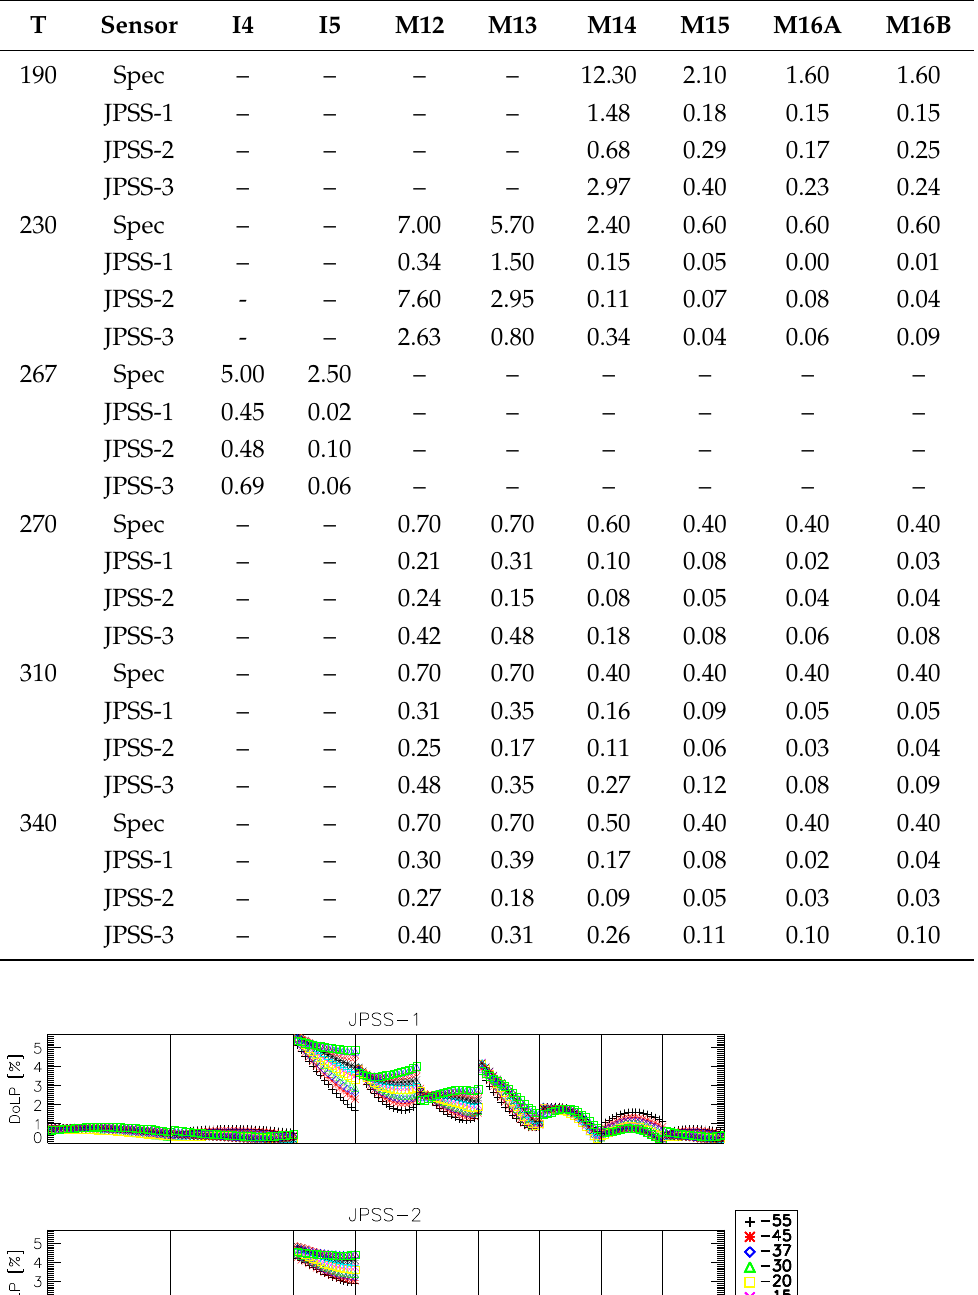
Table 7. JPSS-3 VIIRS TEB ARD in (%) relative to the sensor specification [10].